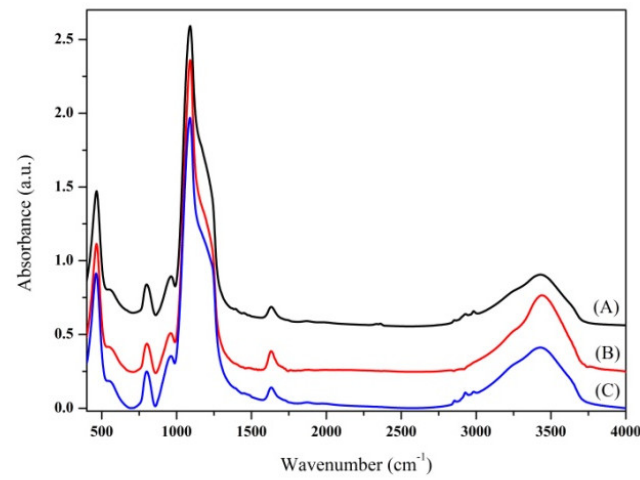
Figure 3. Fourier transform infrared (FT-IR) spectra of (A) WSN-p, calcined WSN (WSN-calc) (B) and WSN-ipa (C).